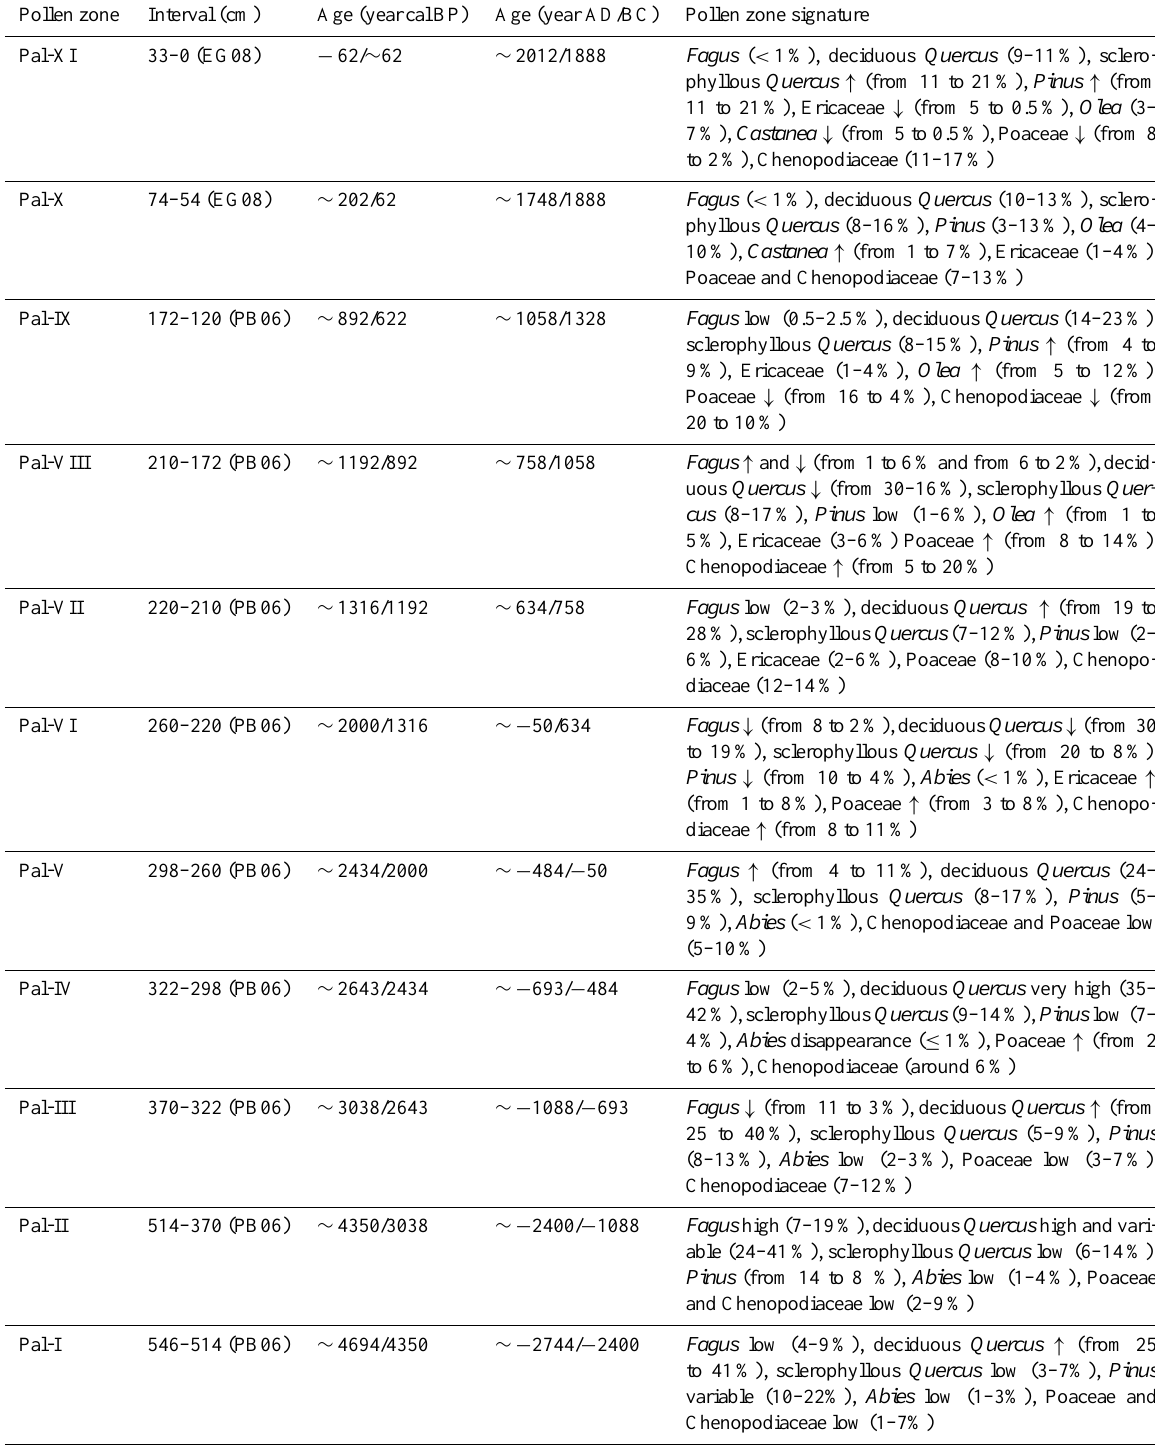
Table 1. Short description of the PB06 and EG08 pollen diagram zonation. Dates in the age columns (separated by slashes) represent upper and lower bounds of the zones. Negative dates refer to dates